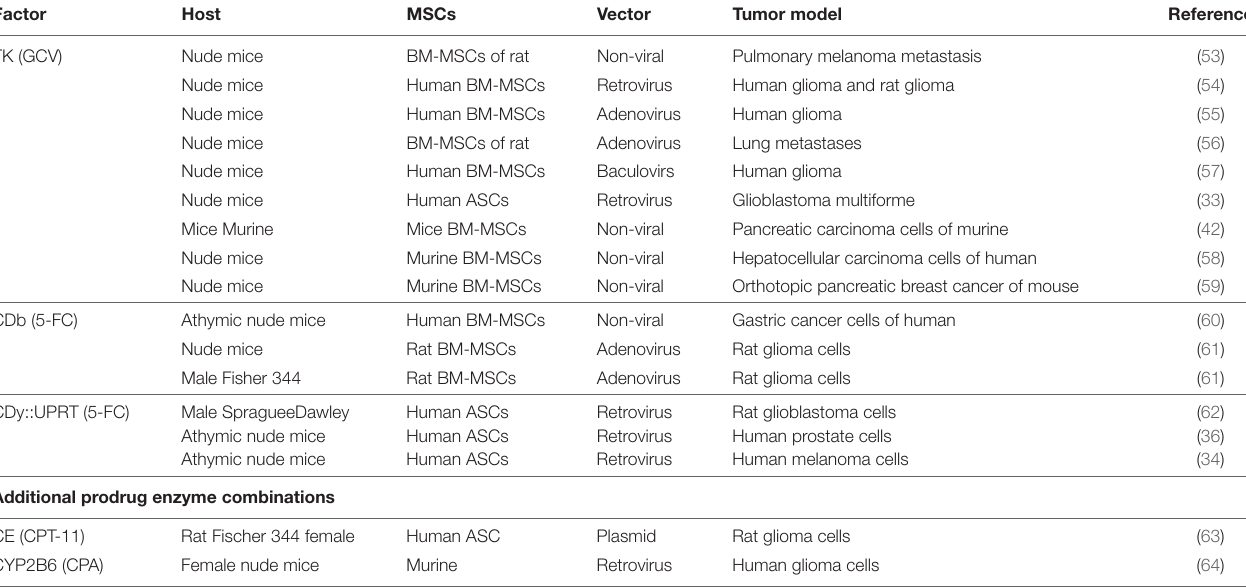
TABle 2 | Gene-directed enzyme pro-drug therapy (GDEPT) of cancers using the various types of mesenchymal stromal/stem cell (MSCs). Factor